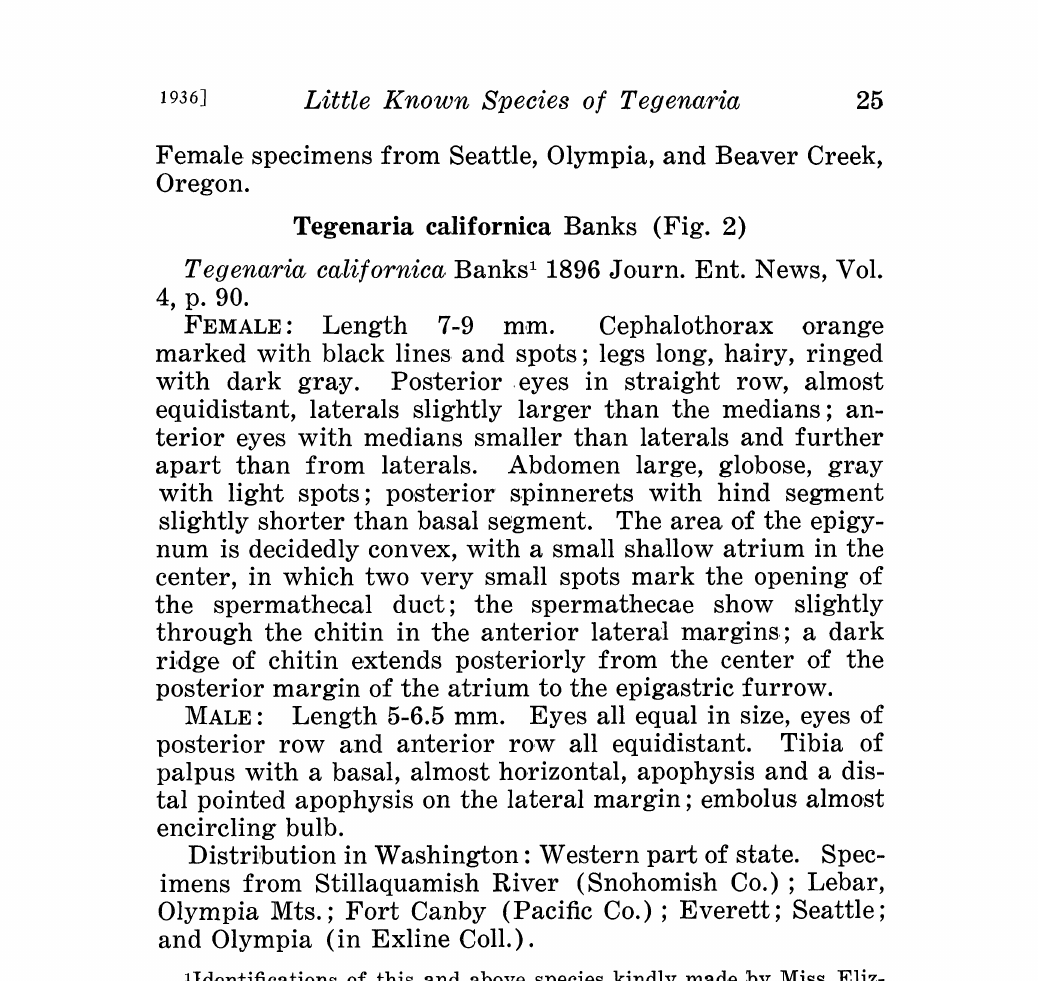
Tegenaria nana Simon. (1, palpus of male, X 29; la, epigynum of female; lb, epigynum of female dissected out from a NaOH solution) X 63. Figure 2, 2a, 2b. Tegenaria californica Banks. (As above.) Figure 3, 3a. Tegenaria gigantea Chamberlin and Ivie. (3, ventral view of’ palpus; 3a, lateral view of palpus) X 13. Figure 4. Tegenaria quadrata n. sp. (Epigynum of female) X 63. Figure 5. Tegenaria magnacava n. sp. (Epigynum of female) X